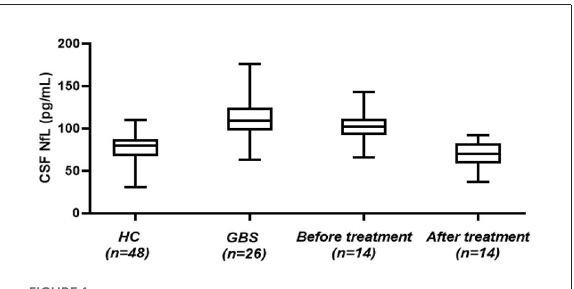
FIGURE1 CSF-NfL levels in GBS patients and healthy controls. Box plots indicate median and IQR with whiskers extending 1.5 times the IQR. CSF-NfL, cerebrospinal fluid neurofilament light chain; GBS, Guillain–Barré syndrome; HC, healthy control.